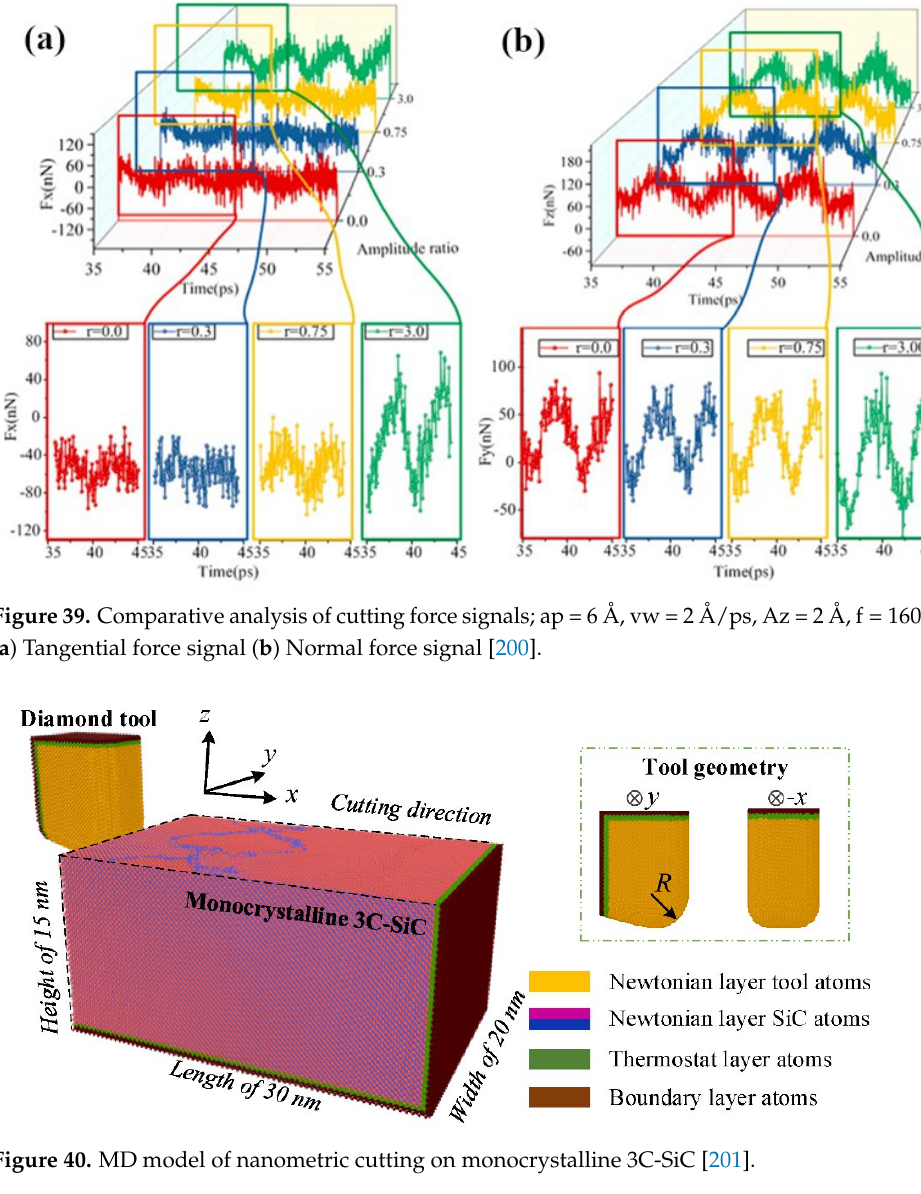
Figure 38. Molecular dynamics model of EVNC [200].